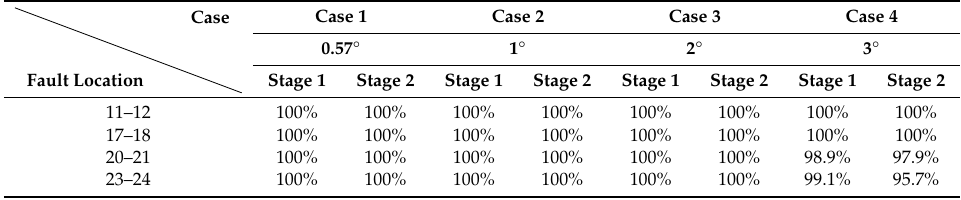
Table 12. Accuracy of fault location according to the phasor angle error (faults in lateral